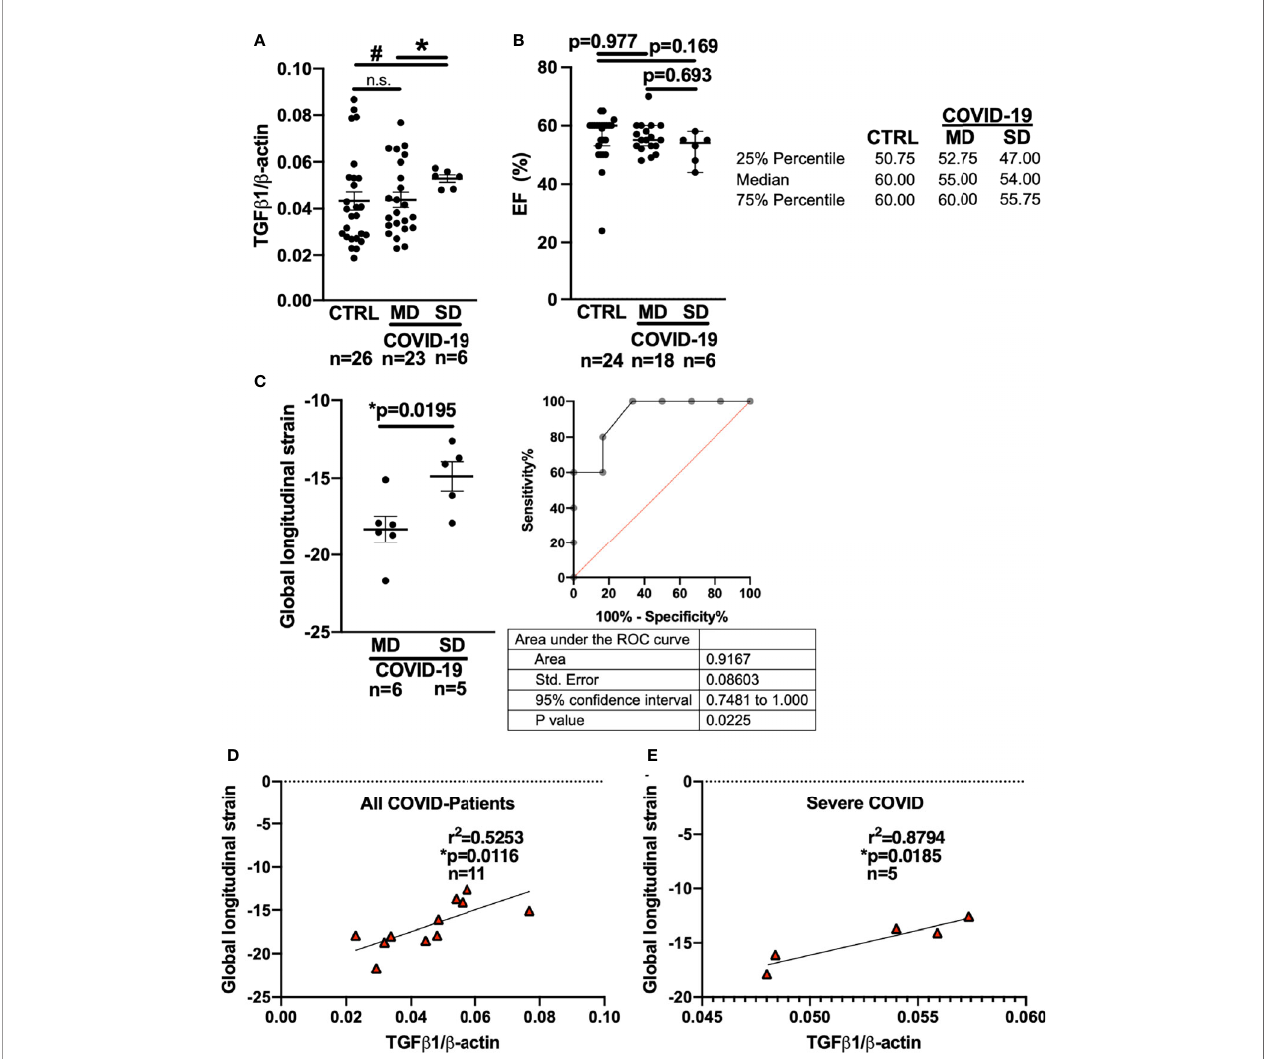
Figure 4C ). As expected, no relevant SARS-CoV-2 nucleocapsid signal was detected in the control